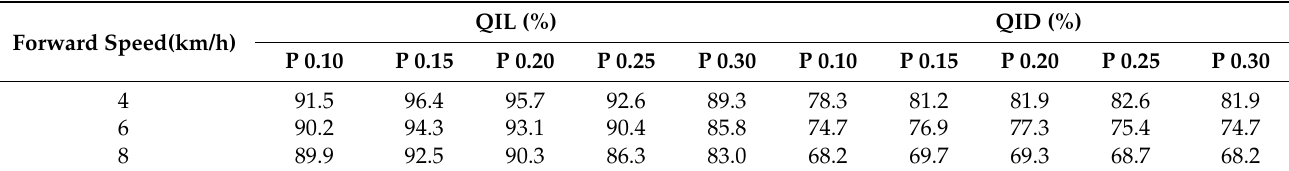
Table 2. Mean value of the qualified index of the length of the liquid starter fertilizer (QIL) and the qualified index of the distance between the seeds and the liquid starter fertilizer (QID) at different forward speeds and pressures. QIL (%) QID (%) Forward Speed(km/h) P